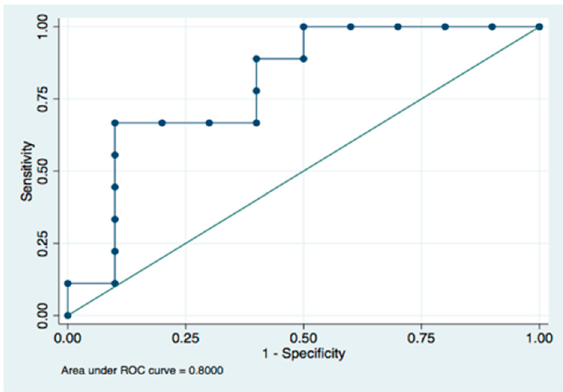
Figure 6. ROC curve for levels of S100B at 72